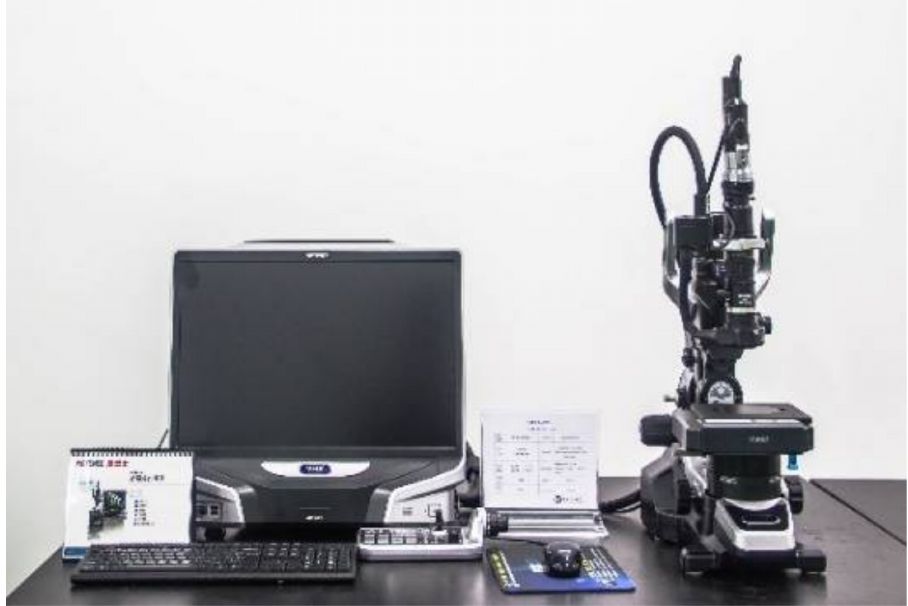
Figure 11. VHX-6000 3D microscope